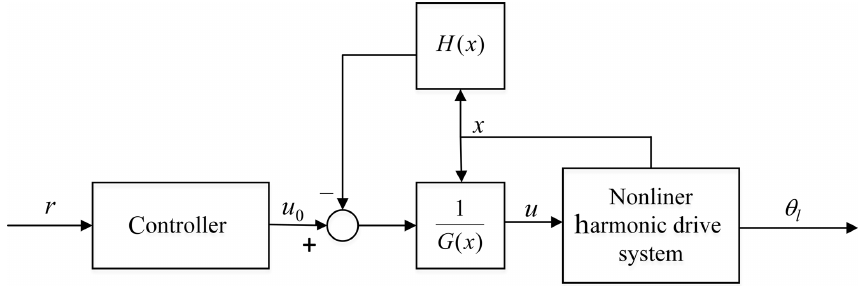
Figure 4. Simplified block diagram of the control system constructed according to Eq. (16).